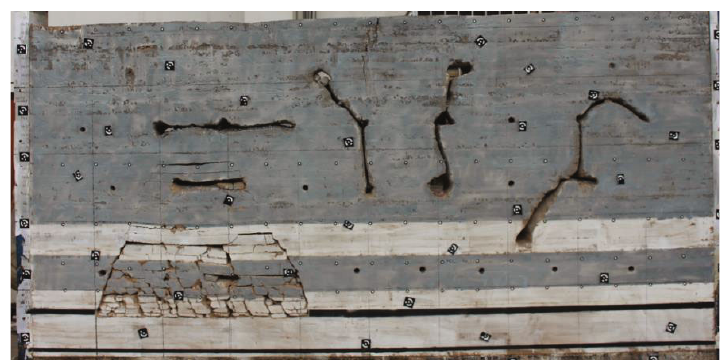
Figure 2: Water inrush passage in the overburden (mining distance is 180 m).